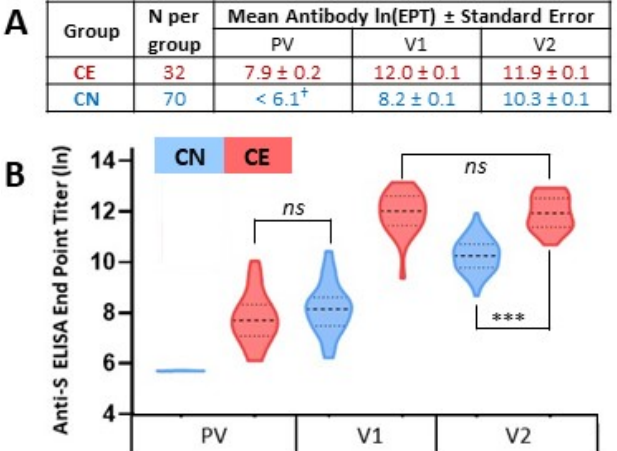
Figure 1. Antibody responses to SARS-CoV-2 mRNA vaccination quantified by anti-spike ELISA. Serially diluted serum samples were subject to hexapro antigen-based ELISA to determine the dilution at which positive antigen-binding was lost, that is, the endpoint titer (EPT). ( A ) The natural log of the mean EPT ± standard error of COVID-19-experienced (CE; red) and COVID-19-naïve (CN; blue) groups were calculated for samples obtained pre-vaccination (PV), 3 weeks after the first vaccine dose (V1), and 3 weeks after the second vaccine dose (V2). ( B ) The natural log of the mean and quartiles are graphed (y-axis). † The lowest antibody dilution tested was 1:450; hence, negative samples were defined as <1:450 and are graphed at a titer of 1:450 (i.e., ln 6.1). ns = not significant. *** represents p < 0.001. Two-sample t -tests were performed for comparisons of CN to CE. Paired t -tests were used for within-group comparisons (e.g., CE from V1 to V2).